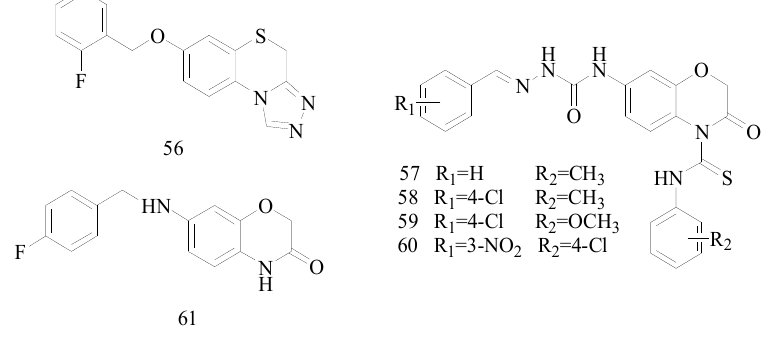
Figure 2. Structures of compounds 56 – 61 .